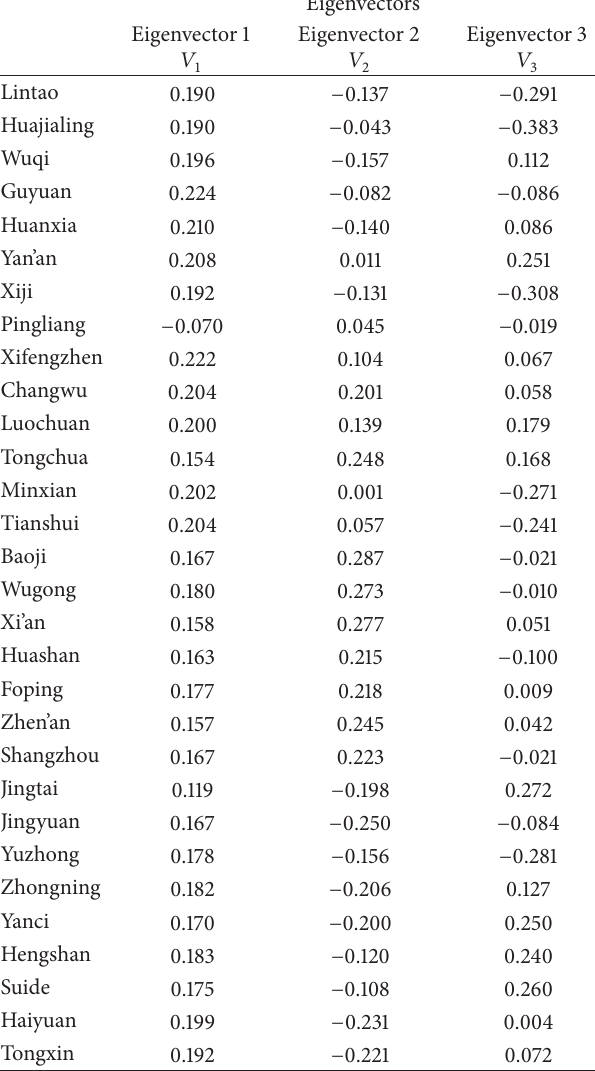
Table2:EigenvectorsobtainedbyEOFdecompositionoftheannual precipitation in the Weihe basin dataset.